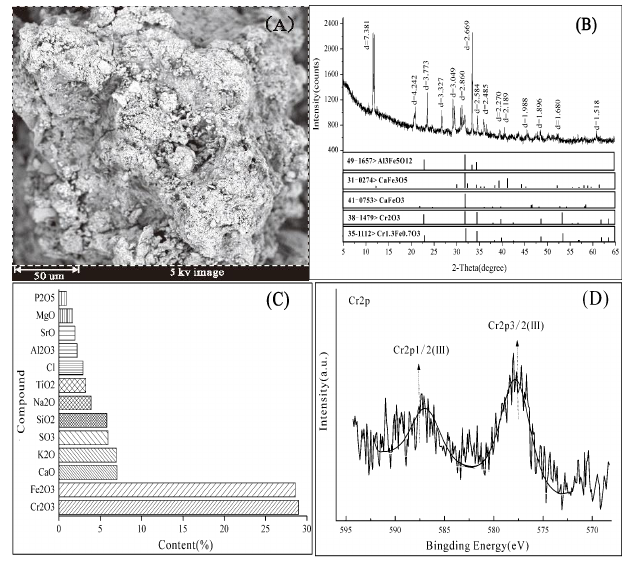
Figure 2. Characterization analysis results of the tannery sludge. ( A ) scanning electron microscope, SEM; ( B ) X-ray diffraction, XRD; ( C ): X-ray fluorescence, XRF; ( D ): X-ray photoelectron spectroscopy,